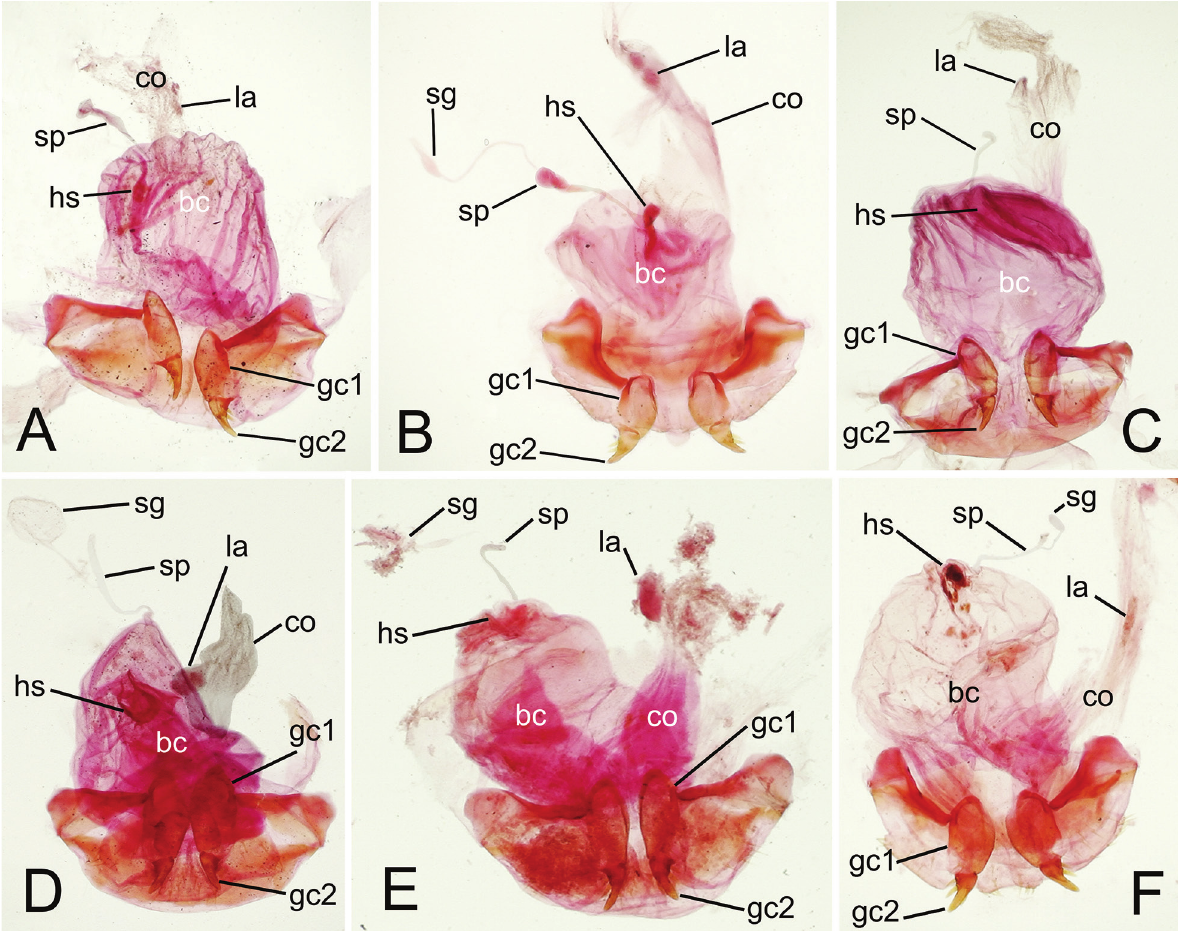
Figure 23. Female reproductive tract, gonocoxites and associated laterotergites, Mecyclothorax ( Phacothorax ) spp: A , M. manautei ; B , M. paniensis ; C , M. mouensis ; D , M. kanak (Mt. Dzumac; common oviduct artificially darkened to show configuration); E , M. kanak (Pic du Grand Kaori); F , M. picdupinsensis . See Table 2 for